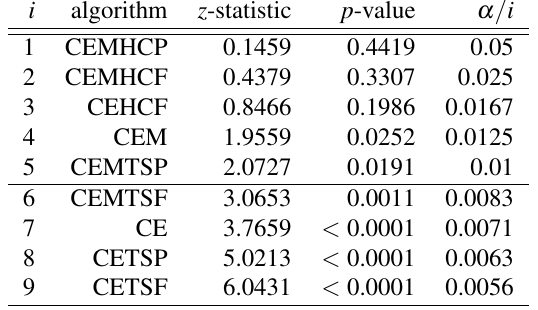
Table 3: Results of Holm’s test using the CEHCP family as control algorithm ( α = 0 :